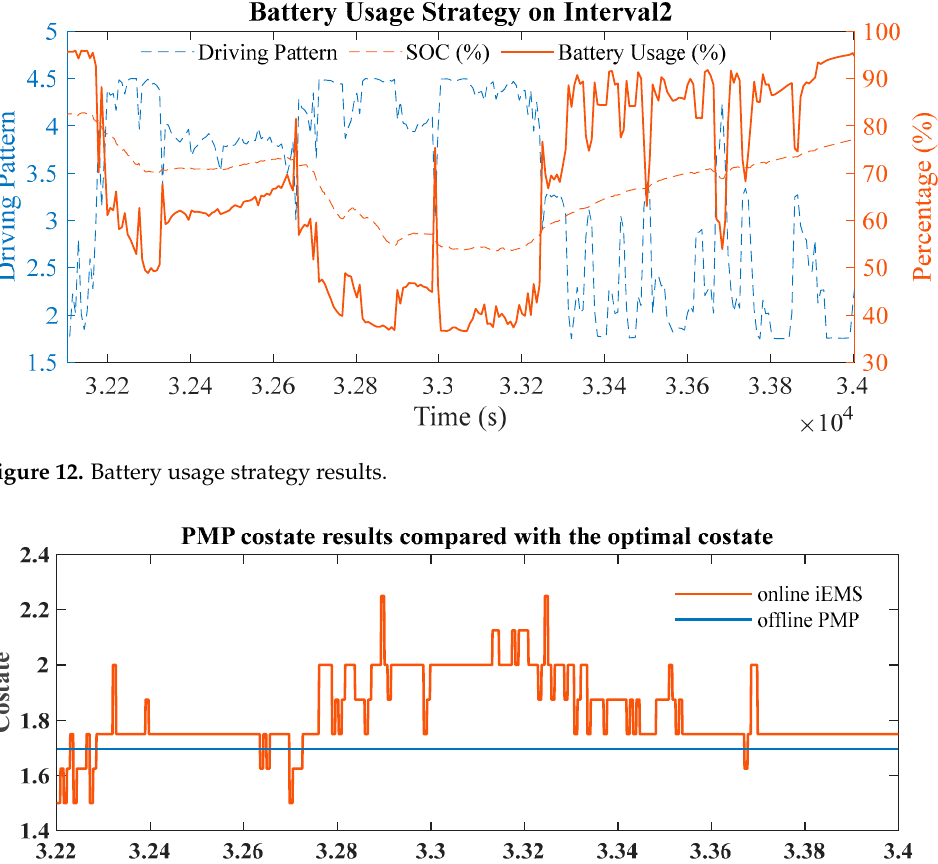
( b ) Figure 14. ( a ) iEMS results on a selected window; ( b ) iEMS compared with the optimal offline PMP.